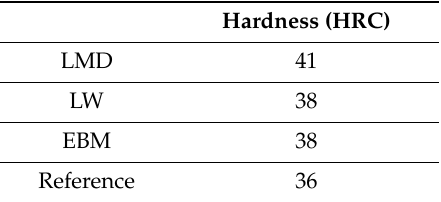
Table 7. Average hardness of AM and reference materials based on three measurements.